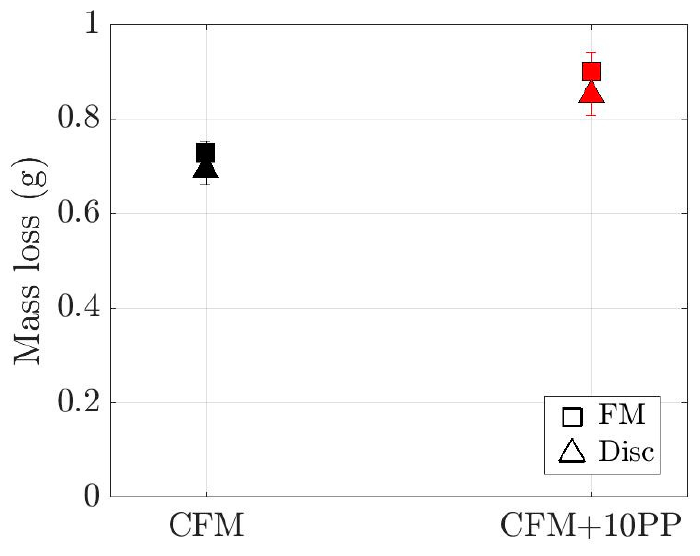
Figure 10. Mass losses for the CFM, CFM with 10 PP, and the respective discs. Regarding the emissions, the evaluation is related to a specific section after the bed- ding procedure when a certain degree of stability is attained. Figure 11 shows the cumula- tive distribution of mean concentrations related to this specific section, which consists of 96 brake stops in the bedding conditions (80 → 30 km/h for the range of speed, 15–46 bar of brake pressure, and an initial disc velocity of 100 ◦ C). For the CFM, the average value is in the range of 950 ± 150 #/cm 3 , whereas the CFM with 10 PP displays values in the range of 1150 ± 250 #/cm 3 . From the cumulative distribution in Figure 11, approx. 20% of the values exceed the maximum values recorded for the original CFM. Although the emissions on the CFM with 10 PP are only slightly higher than the original formulation, the comparable emission behavior can be considered as a promising result.